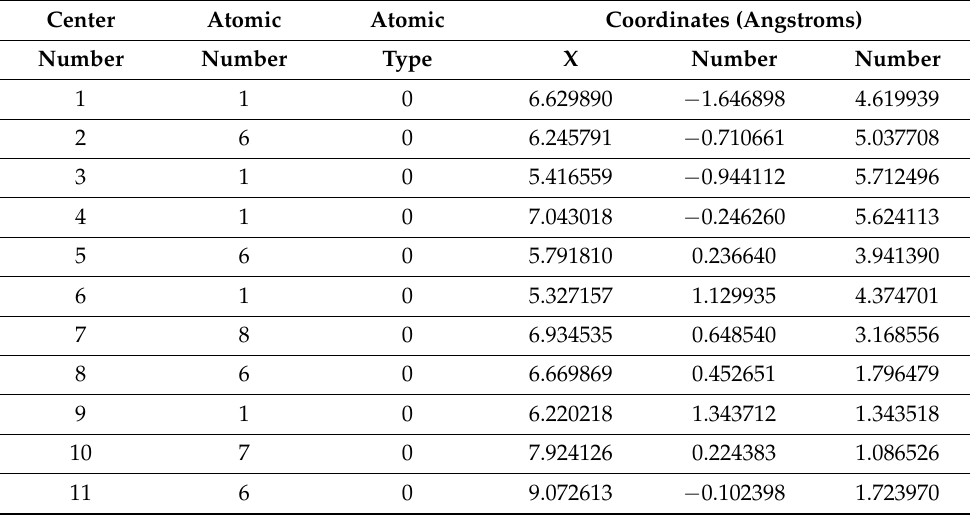
Table A12. Complex LiI 3 with nucleotide triplet